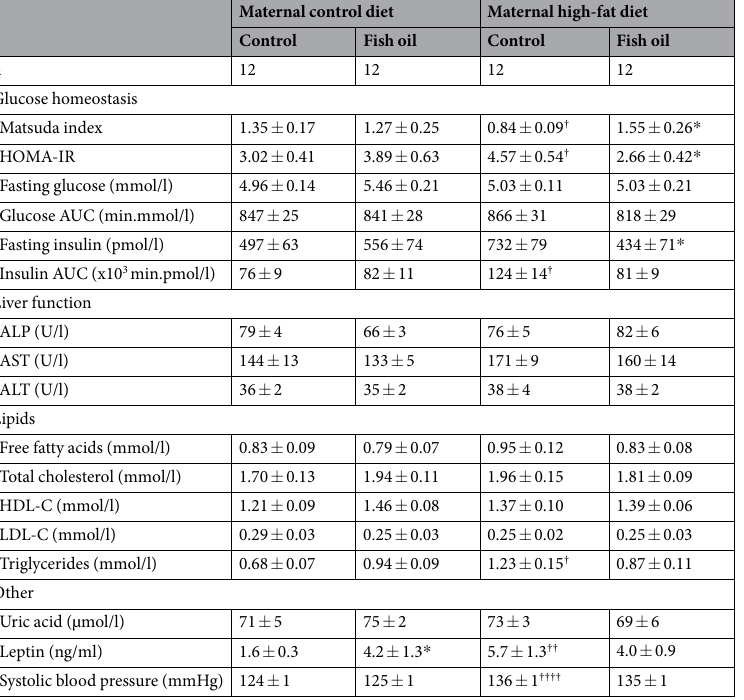
Table 5. Study outcomes among adult male offspring according to the maternal diet (control or high-fat), and gavage treatment during pregnancy [fish oil or control (water)]. Data are means ± standard errors. † p < 0.05, †† p < 0.01, and †††† p < 0.0001 for a maternal diet effect among the offspring of dams that received control gavage; * p < 0.05 and ** p < 0.01 for an effect of the gavage treatment between groups exposed to the same